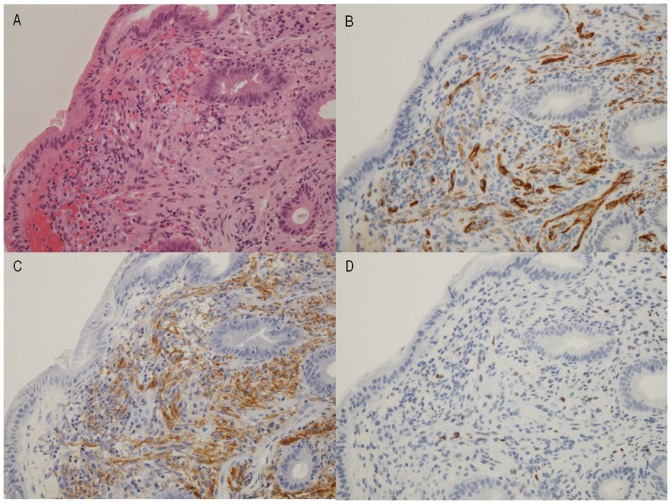
Pathological features of GI-KS.
A) Spindle cell proliferation found in the submucosa on hematoxylin and eosin (HE) staining. B) Immunohistochemical staining revealing strong expression of CD34. C) Immunohistochemical staining revealing expression of D2–40. Vascular gaps are lined with endothelial cells on staining for CD34 and D2–40. D) Some endothelial cells are positive for human herpes virus 8 (HHV-8).